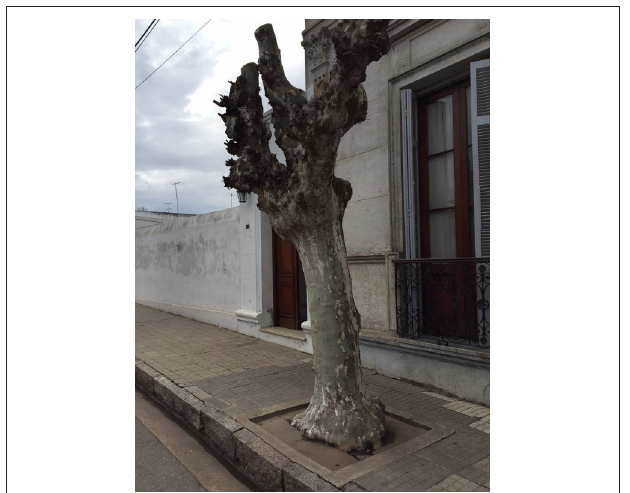
FIGURE 1 | Tree management.